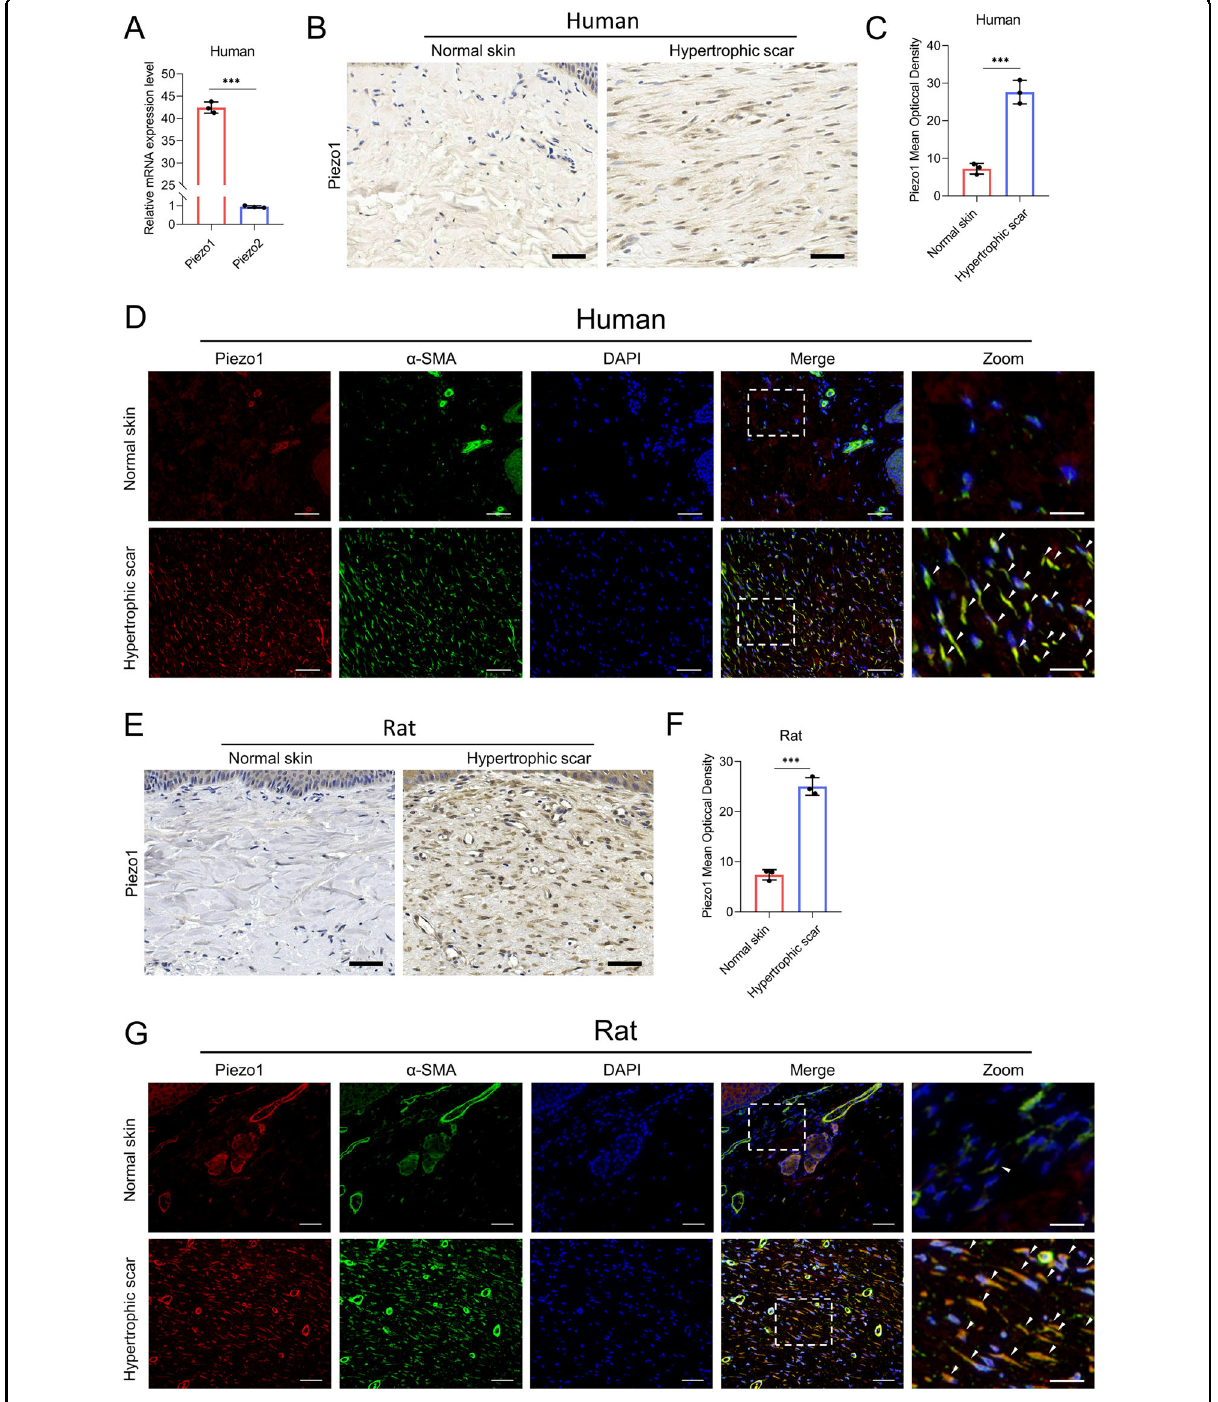
Fig. 1 Piezo1 expression in normal skin and HS tissues. A The relative expression of Piezo1 and Piezo2 mRNA from HDFs was analyzed by real-time RT-PCR. B , C Images and quantitative analysis of Piezo1 in human normal skin and HS. (Scale bar = 50 μ m). The basal epithelial layer was excluded from quantitation. D Images of immuno fl uorescence co-staining of Piezo1 and α -SMA in human normal skin and HS. Piezo1 are labeled in red and α -SMA in green. (Scale bar = 100 μ m). Scale bars for the zoom images, 20µm. E , F Images and quantitative analysis of immunohistochemistry staining of Piezo1 in rat normal skin and HS. (Scale bar = 50 μ m). The basal epithelial layer was excluded from quantitation. G Images of immuno fl uorescence co-staining of Piezo1 and α -SMA in rat normal skin and HS. Piezo1 are labeled in red and α -SMA in green. (Scale bar = 100 μ m). Scale bars for the zoom images, 20µm. The arrowheads point to the fi broblasts. The results are expressed as the means with SD ( n = 3). The T -test is used for all analysis. *** P